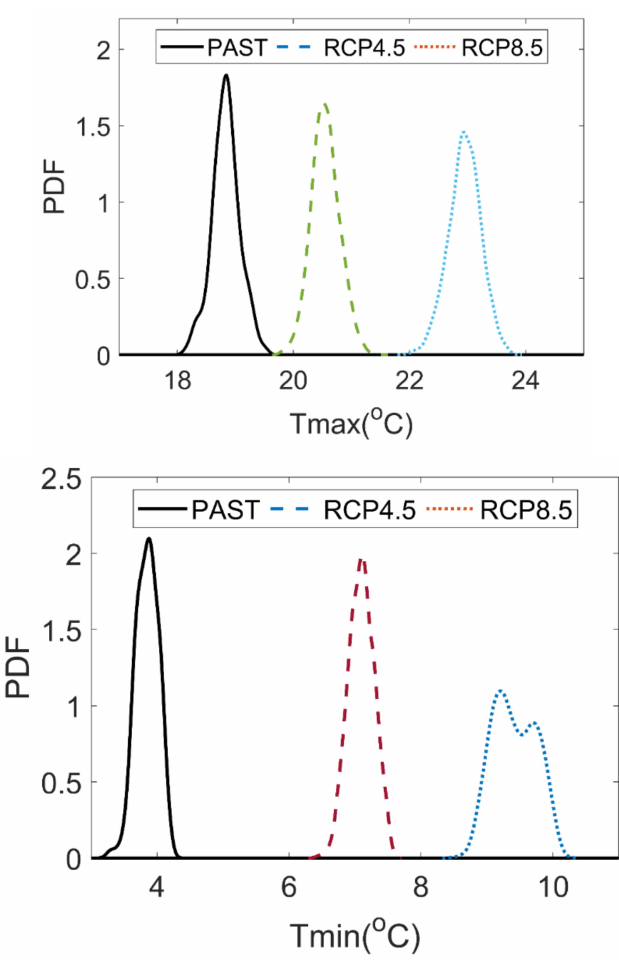
Figure 5. The annual maximum (Tmax) and minimum (Tmin) temperatures used to drive the hydrologic